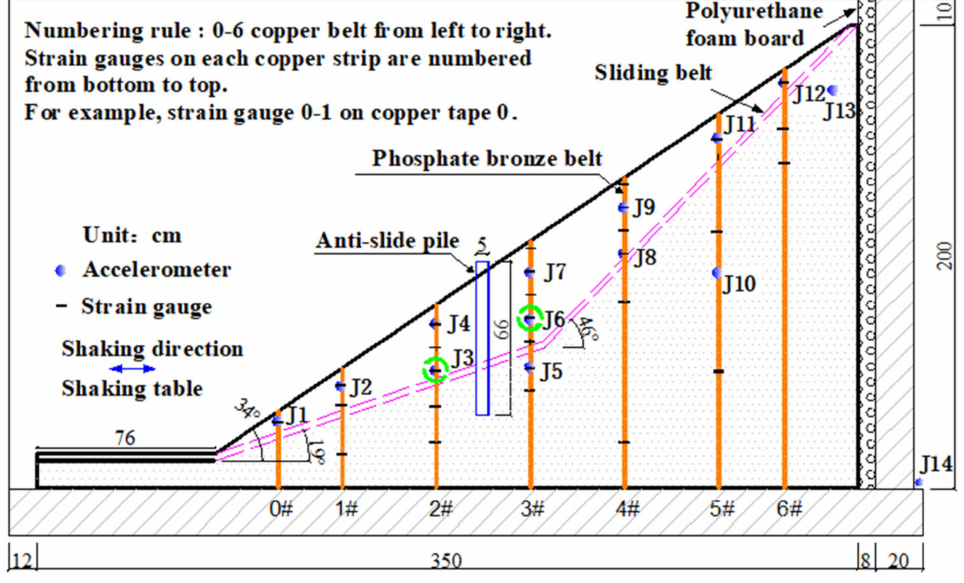
Figure 5. Test components layout.